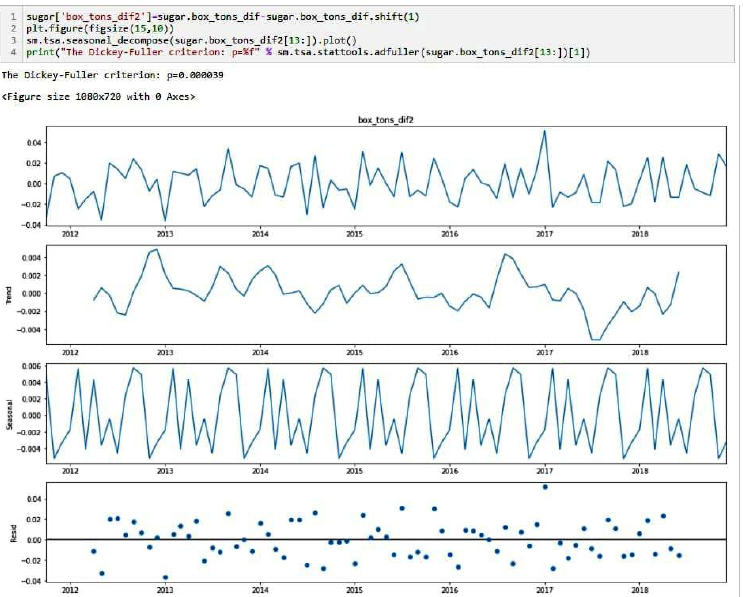
Figure 8. Application of normal differentiation and decomposition of a time series into